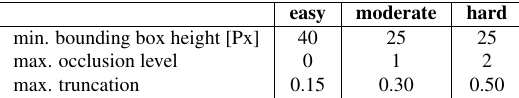
Table 1. Levels of difficulty for the